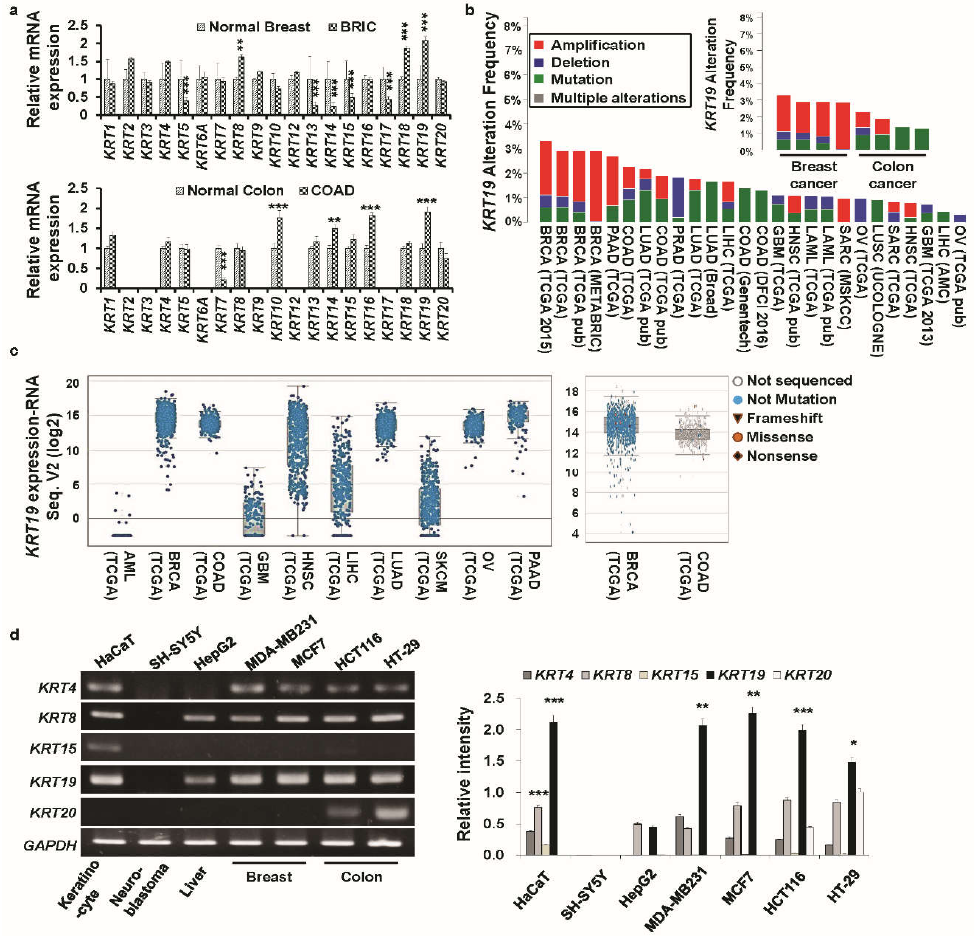
Figure 1. Expression of different Keratins ( KRTs ) family genes in various cancers. ( a )